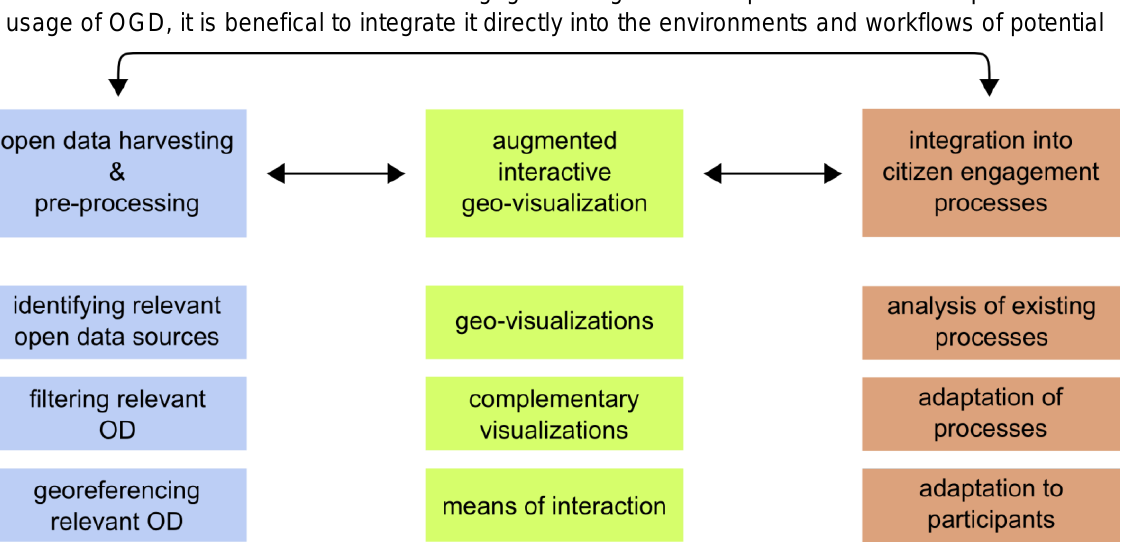
Figure 1: Three central challenges are present in order to realize and use augmented interactive geo- visualizations. Each challenge consists out of interdependent steps that need to be taken. For a geo- visualization Open (Government) Data needs to be harvested and pre-processed, the augmented interactive geo-visualization has to fit into the entire citizen engagement process that informs the means of interaction and possibly complementary visualizations. Furthermore the existing processes have to be adapted to the interactive geo-visualization, while the process and utilized geo- visualization itself has to be adapted to the